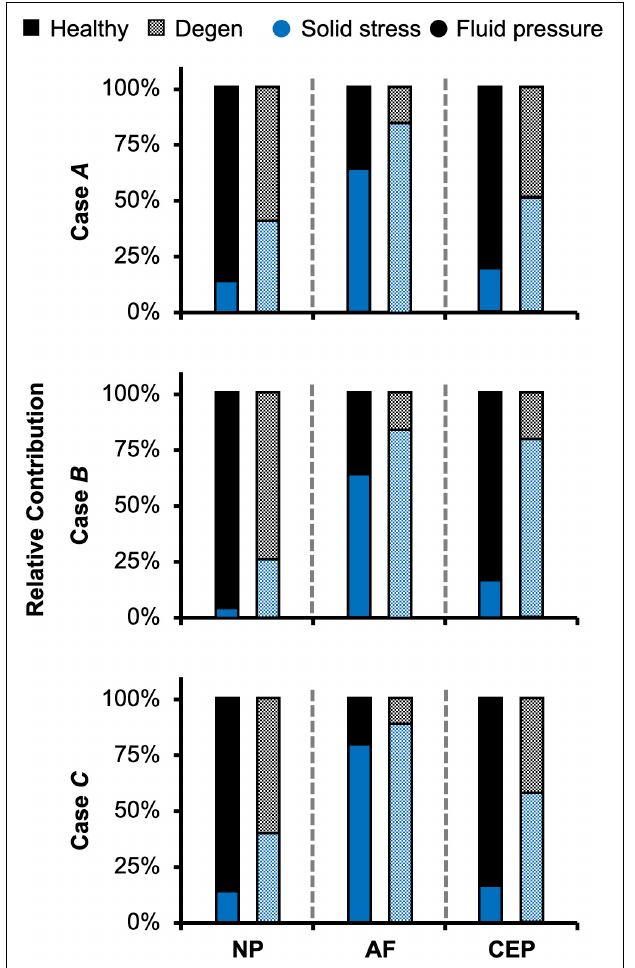
FIGURE 8 | Model-predicted relative contribution of solid stress and fluid pressure in the nucleus pulposus (NP), annulus fibrosus (AF), and cartilage endplate (CEP) in healthy and degenerated (Degen) disc models for Cases A , B , and C after the applied mechanical loading.